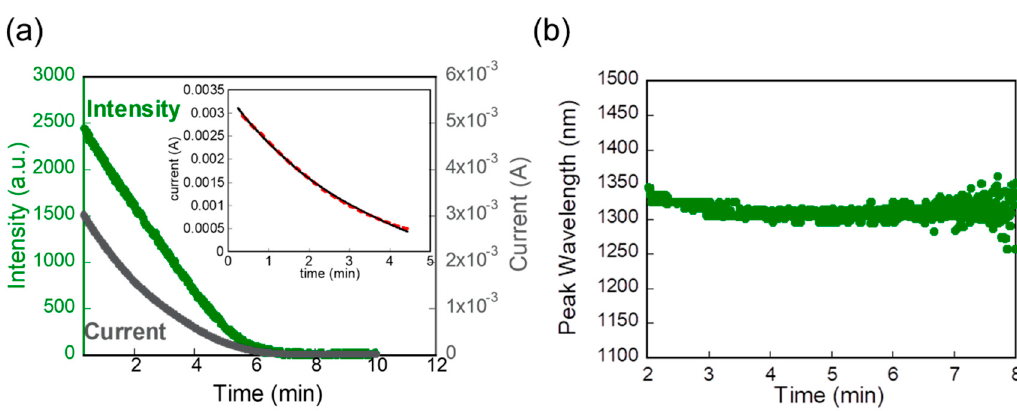
Figure 6. ( a ) Plots of EL intensity and current as a function of time during emission. An applied voltage is 1.5 V. The inset shows the current decay plots to calculate the stretched exponential fitting parameters ( τ = 161 s and β = 1.3). The black and red-dashed curves represent fit and experimental data, respectively. ( b ) A plot of peak wavelength as a function of time during emission.